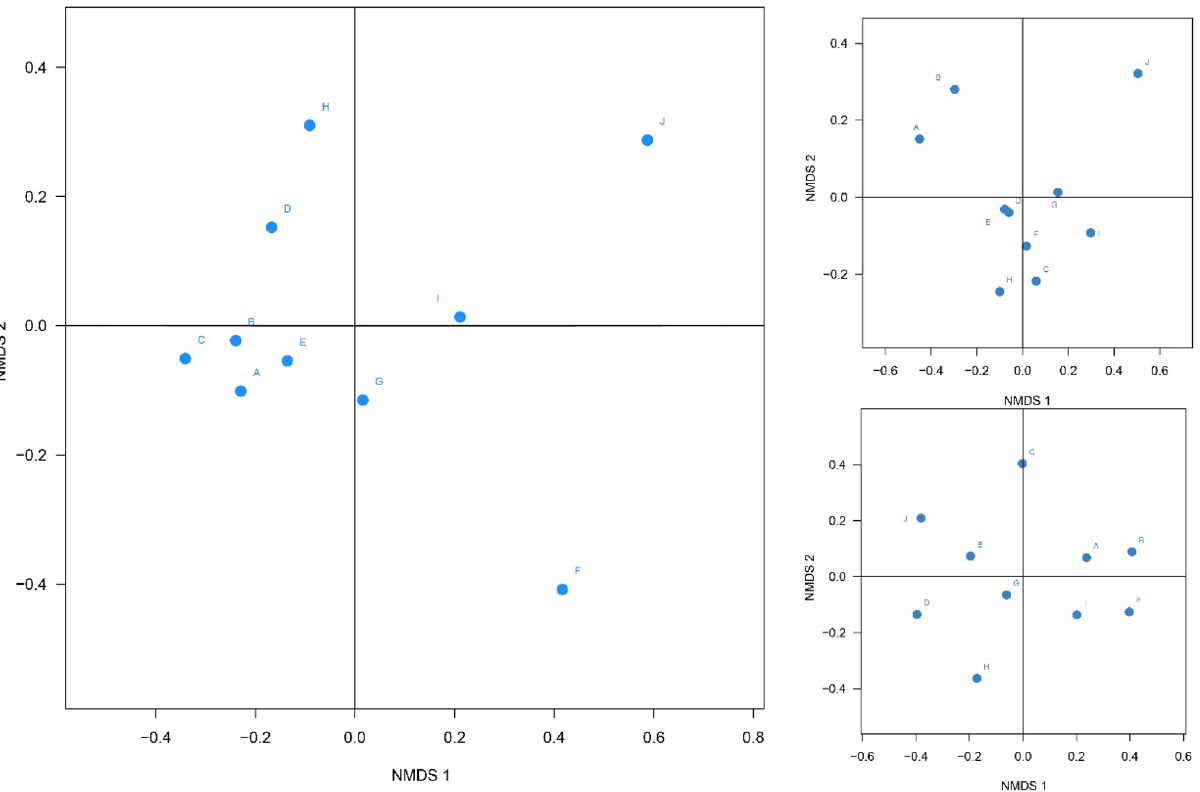
Figure 5. Nonmetric multidimensional scaling map (May, August, and October).